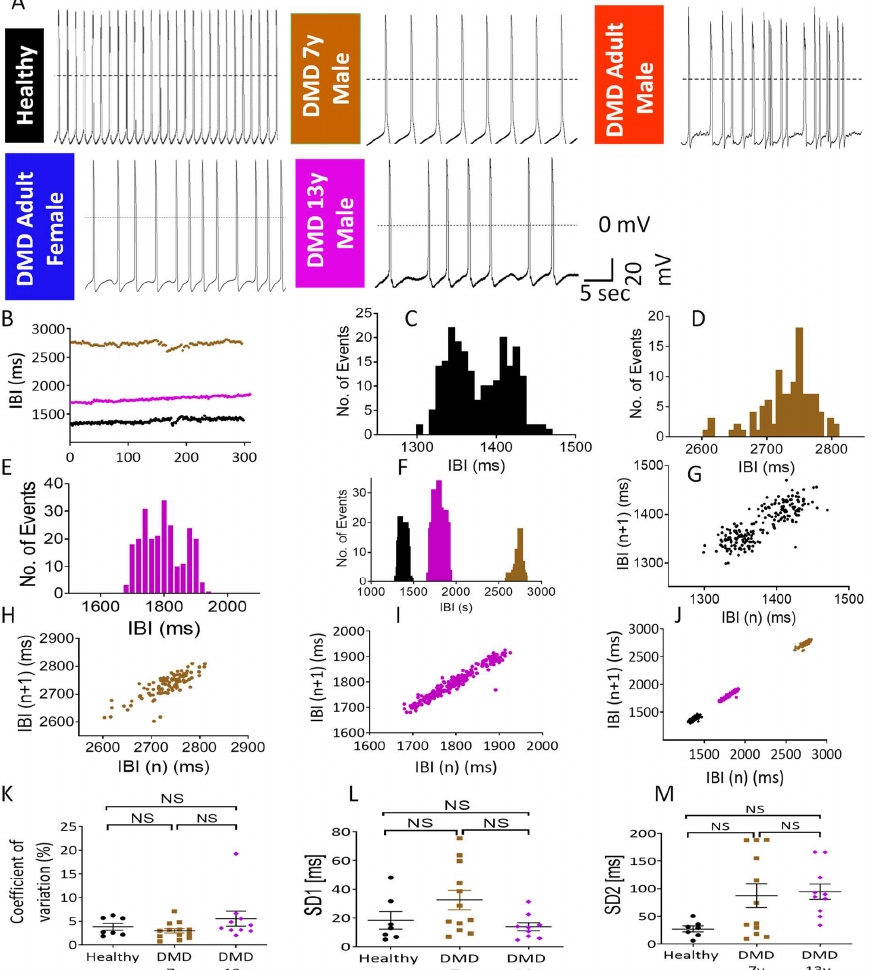
Figure 2. Electrophysiological features and action potential characteristics of spontaneously firing healthy and DMD iPSC-CMs. ( A ) Representative action potentials recorded from iPSC-CMs generated from the healthy control (firing regularly), DMD 7year old male (7y) (firing regularly) and the DMD adult male, adult female and 13 year old (13y) male, all displaying arrhythmogenic firing patterns. ( B–M ) Beat rate variability (BRV) analysis of spontaneously firing CMs from the 5 experimental groups. ( B ) Superimposed representative inter-beat interval (IBI) vs. time plots of healthy (black symbols), DMD 7y (brown symbols) and DMD 13y (purple symbols) iPSC-CMs. ( C – E ) Representative IBI histograms for the experiments shown in ( B ). ( F ) Superimposed IBI histograms for the three groups. Poincaré plots of healthy ( G ), DMD 7y ( H ) and DMD 13y ( I ) CMs. ( J ) Superimposed Poincaré plots for the three groups. ( K ) Coefficient of variation analysis. ( L ) Standard deviation 1 (SD1) analysis. ( M ) SD2 analysis. Healthy, n = 7; DMD 7y, n = 13; DMD 13y, n = 10. Kruskal–Wallis test for non-normal distribution; NS = non-significant.